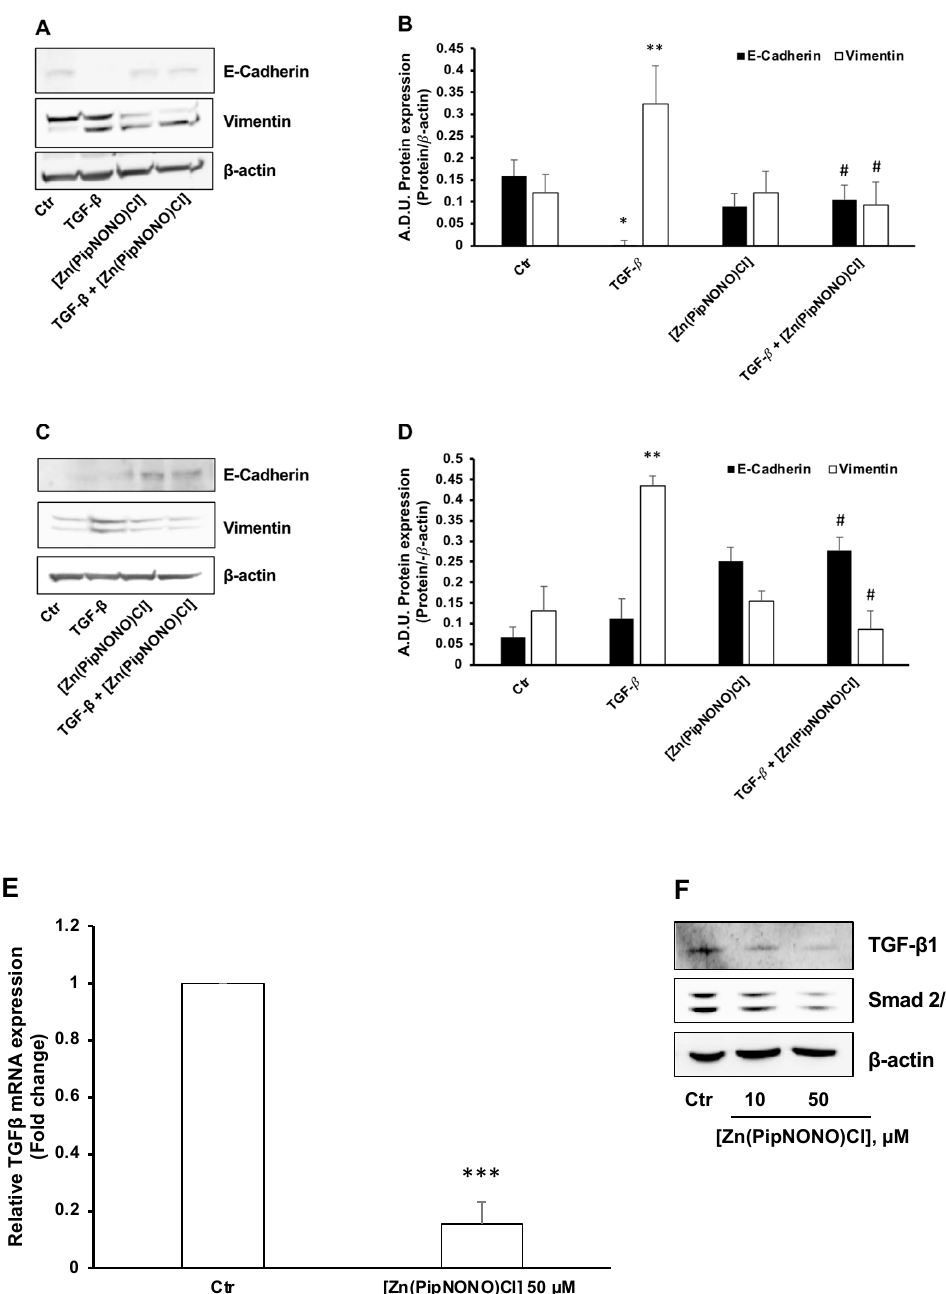
Figure 3. Effect of [Zn(PipNONO)Cl] on EMT induced in tumor cells by exposure to TGF- β 1 and on the autocrine TGF- β signaling loop. EMT protein markers were monitored in A549 ( A , B ) and A375 ( C , D ) cells exposed for 96 h with 10 ng/mL TGF- β 1 in the absence and in the presence of 50 µM [Zn(PipNONO)Cl] in medium with 0.5% FBS. * p < 0.05 and ** p < 0.01 TGF- β 1 vs. control (Ctr); # p < 0.05 [Zn(PipNONO)Cl] + TGF- β 1 vs. TGF- β 1 alone. A representative blot of 3 independent experiments is reported. β -actin was used as a loading control. ( E ). TGF- β 1 gene expression in A549 treated with [Zn(PipNONO)Cl] for 18 h in medium with 2% serum. Data are reported as fold changes relative to A549 untreated (Ctr), assigned to 1. *** p < 0.001 vs. A549 Ctr. ( F ). TGF- β 1 and Smad2/3 protein expression in A549 treated with [Zn(PipNONO)Cl] for 18 h in medium with 2% FBS. Representative blots of 3 independent experiments are reported. β -actin was used as a loading control. Whole uncropped blots and densitometry intensity ratio related to panel F are reported in Supplemental material (Figure S1 and Table S1).